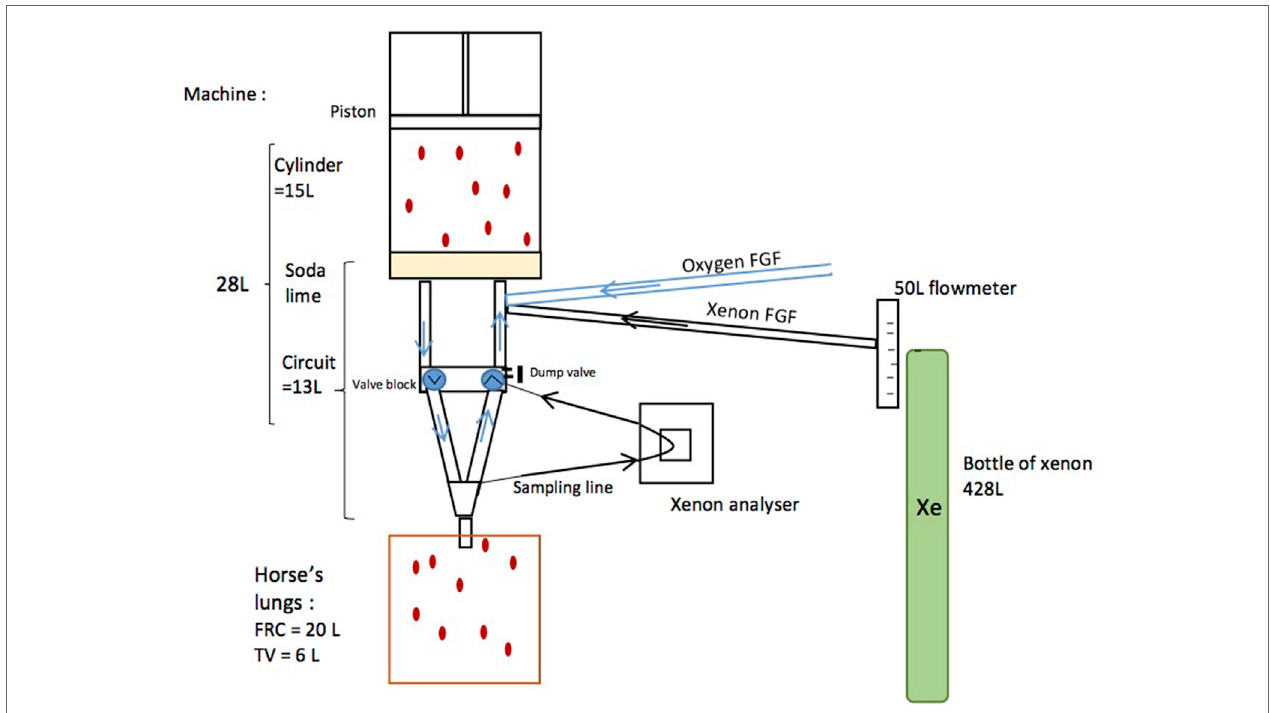
FigUre 1 | Schematics of a modified Tafonius machine. Xenon was directly taken from a 428-L xenon cylinder connected to a 50-L min − 1 flow meter and then delivered by a pipe into the bottom of the machine cylinder. A xenon analyzer was connected to the expired limb and sampled expired gases were re-introduced into the bottom of the machine cylinder.